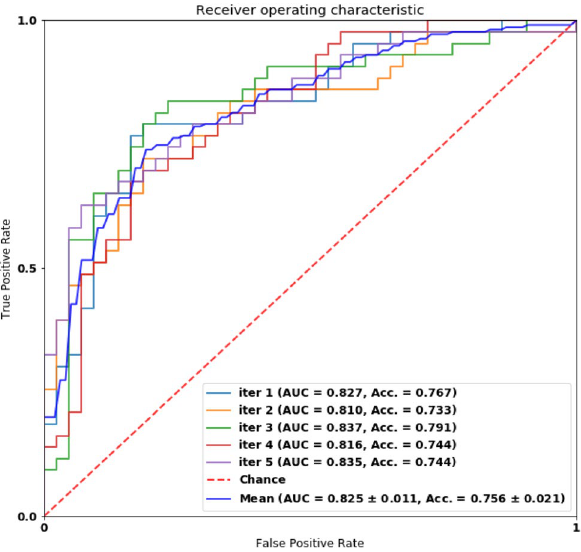
Figure 6. AUROC of classifying MCI against HC on the Pitt